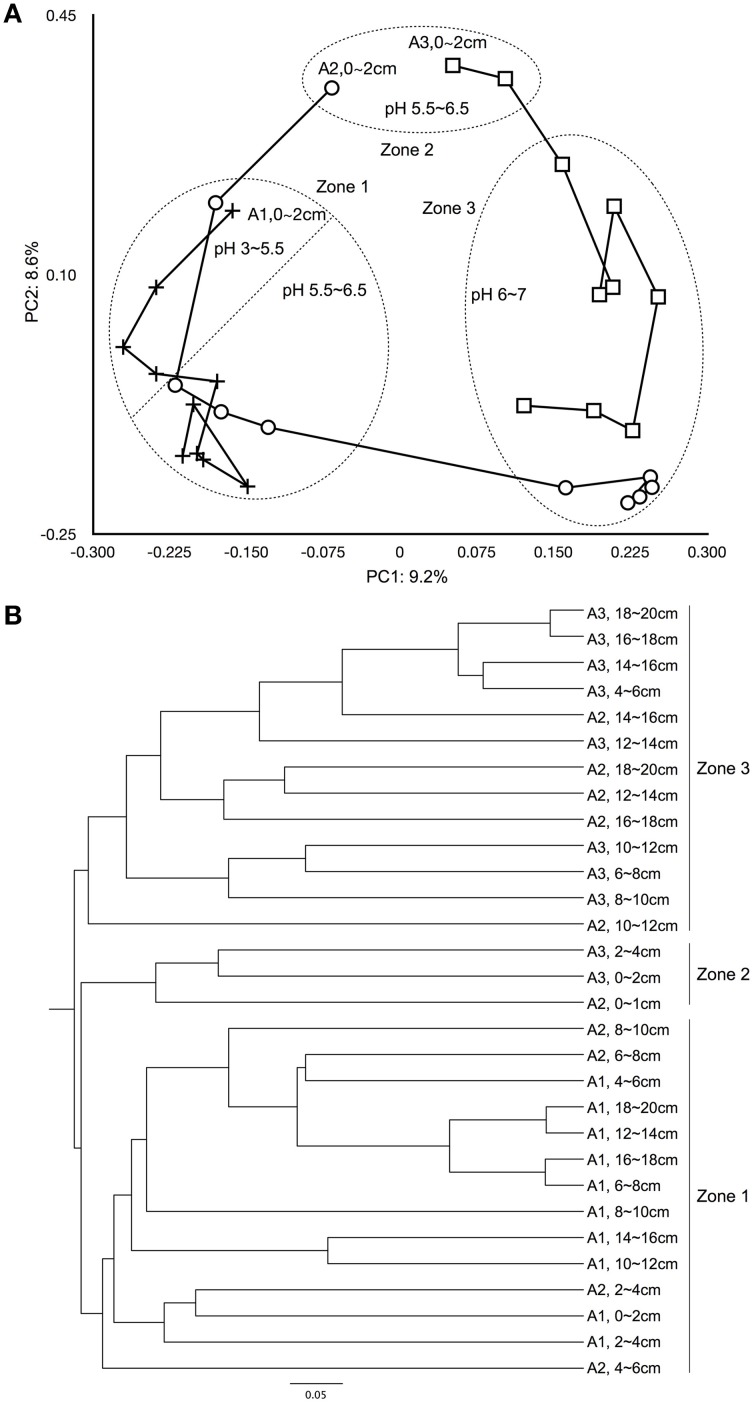
Beta diversity analysis comparing microbial structure similarity among samples. (A) Principal coordination analysis among samples from the Jaccard calculator (PC1 = 9.2%, PC2 = 8.6%). The “+” represents samples from site A1, the “○” represents samples from site A2, and the “□” represents samples from site A3. (B) Yue and Clayton measure of samples similarity.